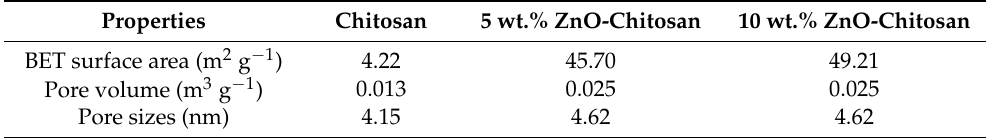
Table 1. N 2 adsorption–desorption properties of chitosan and the composites.